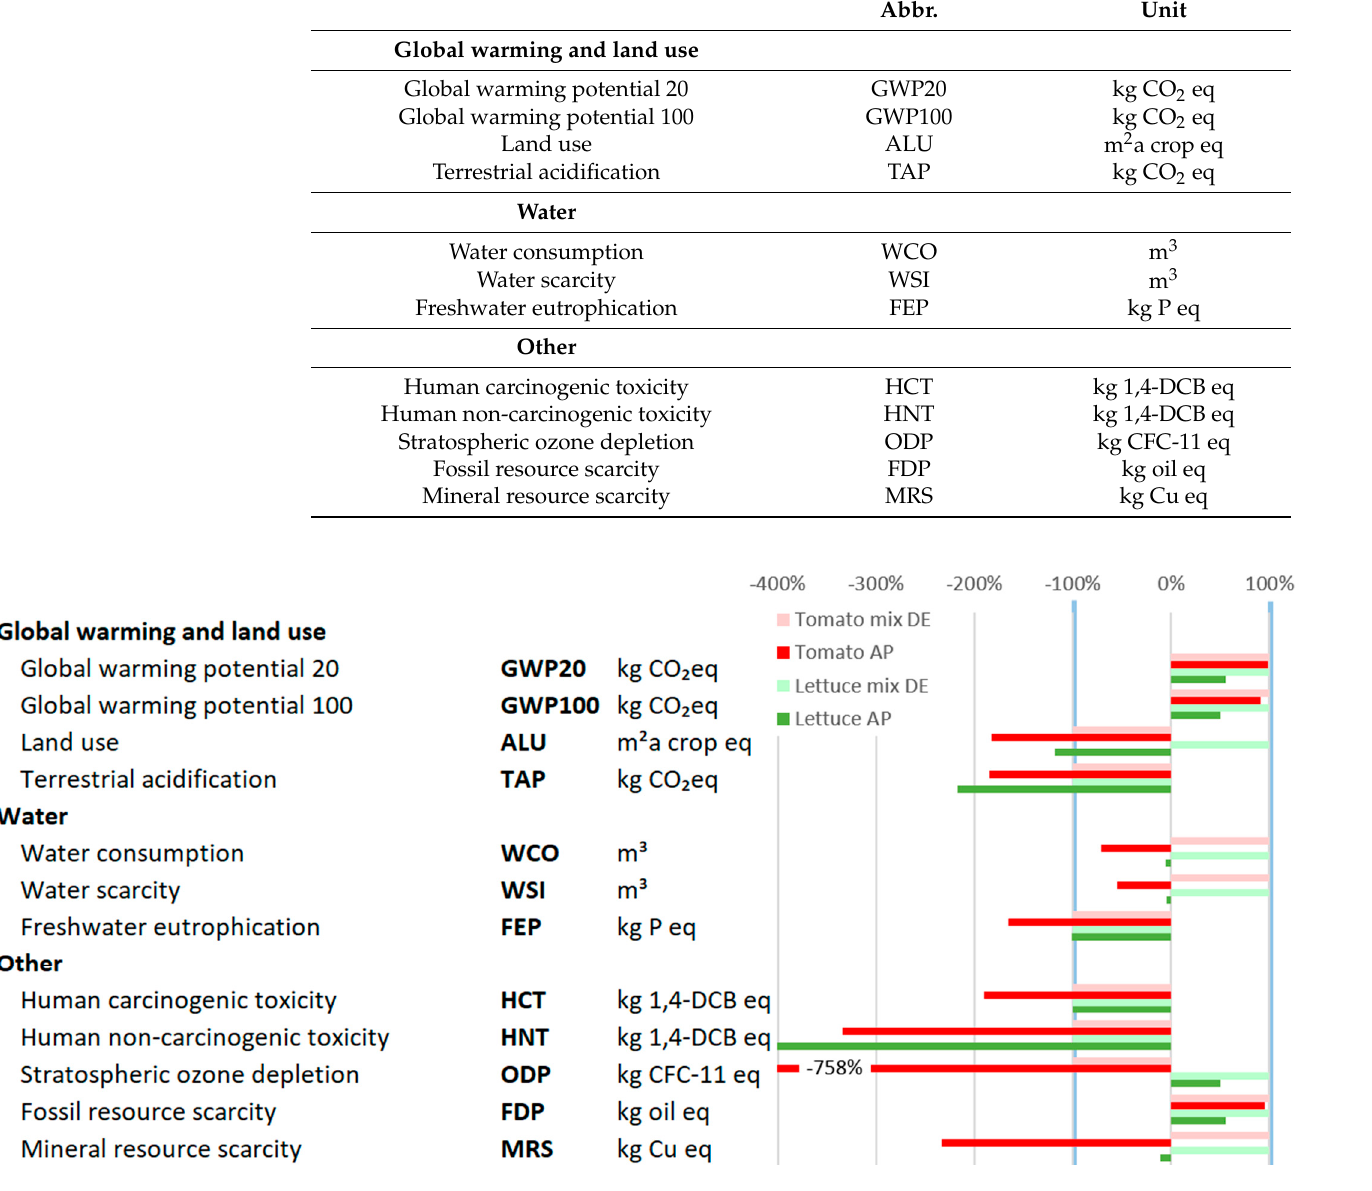
Figure 2. Relative change in LCA impact categories for optimised rooftop-aquaponics (AP) compared to the German market mix for fresh tomatoes and lettuce (mix DE) as +/ − 100%; authors work and the calculation based on data from comparative-LCA [41].